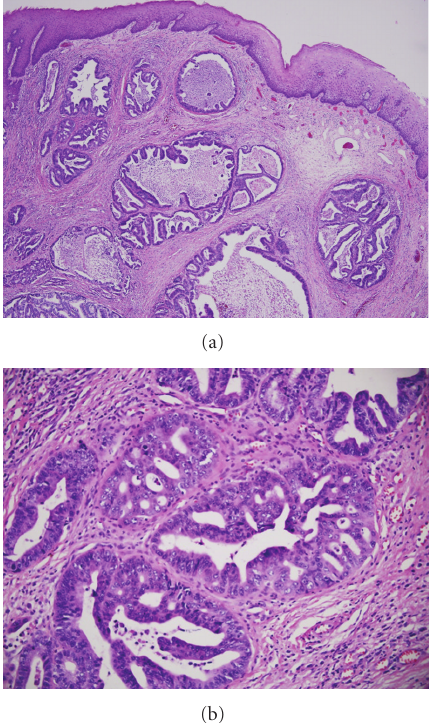
Figure 2: (a) H&E stain ( × 40 magnification) shows moderately di ff erentiated adenocarcinoma in the deep mucosa beneath intact squamous epithelium. (b) H&E stain ( × 100 magnification) shows cribriform glands and micropapillae infiltrating stroma of the lamina propria with moderate cellular